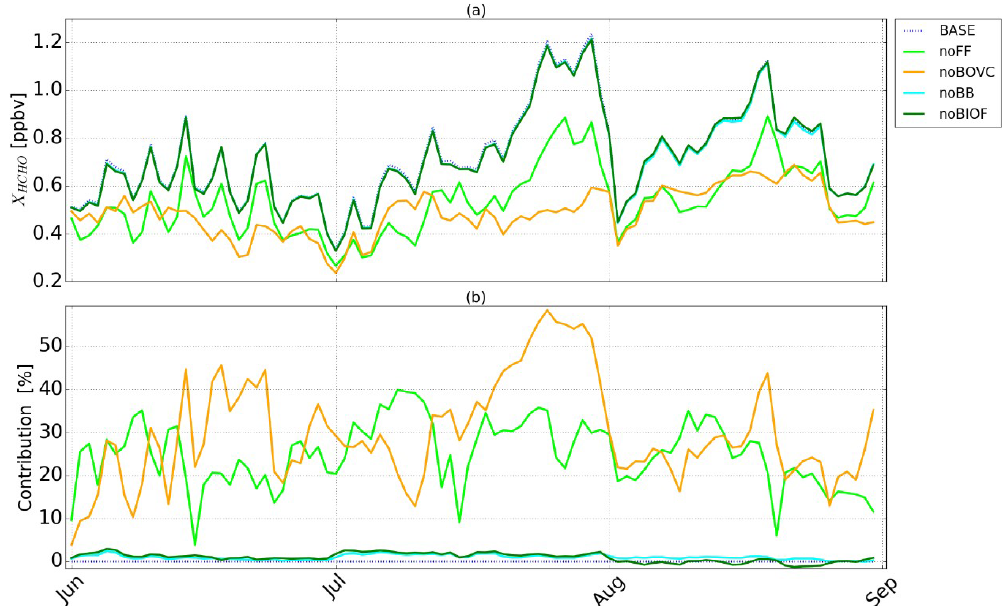
Figure 7. (a) Daily mean X HCHO (in ppbv) time series averaged over the summertime of 2015 to 2019 above Hefei simulated by GEOS- Chem, according to the BASE and sensitivity (i.e., noFF, noBVOC, noBB, and noBIOF) simulations. In the sensitivity simulations, the fossil fuel, biogenic, biomass burning and biofuel emissions of all atmospheric compounds have been shut off globally, while the CH 4 concentrations are still derived from NOAA measurements, as for the BASE simulation. (b) Relative contribution of each emission category calculated as the relative difference between the BASE simulation and the corresponding sensitivity simulation (in